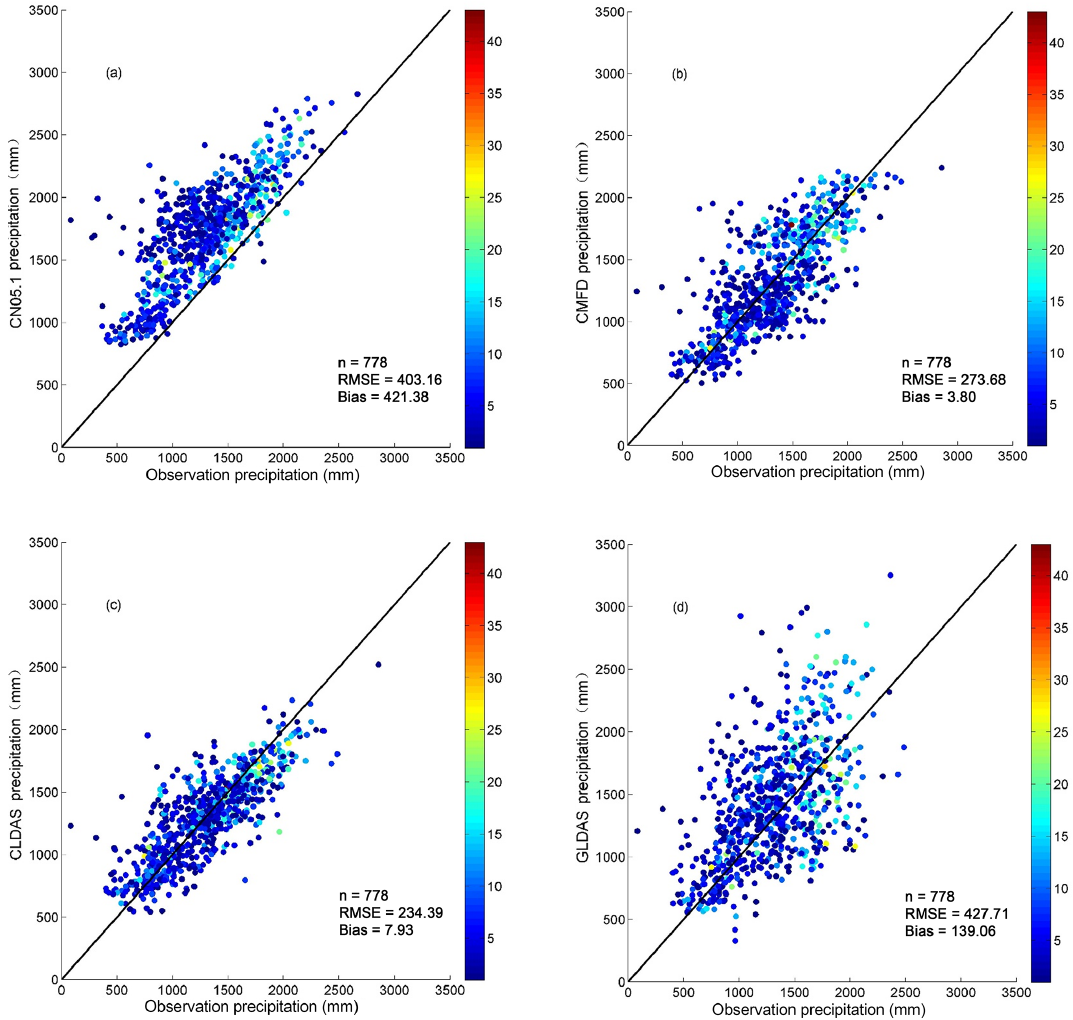
Figure 6. Comparison of the precipitation from (a) CN05.1, (b) CMFD, (c) CLDAS and (d) GLDAS against mutually independent rain gauge observations from MWR. The color bar on the right indicates the number of MWR rain gauges in the corresponding 0.25 ◦ × 0.25 ◦ grid